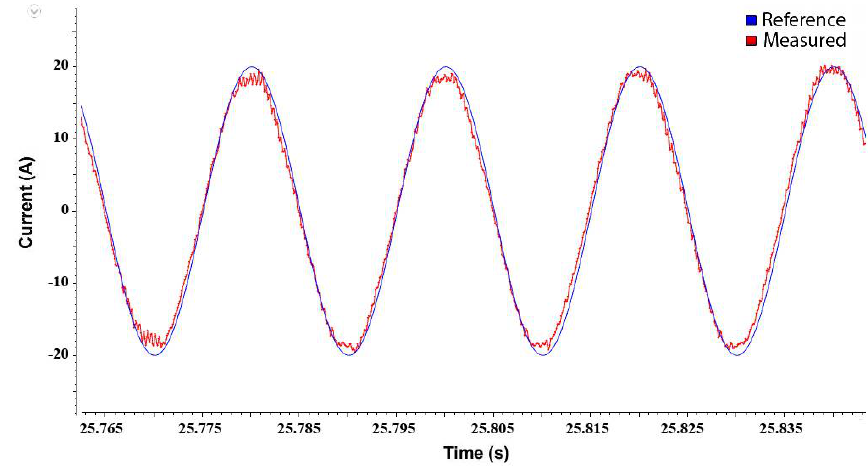
Figure 13. DSPACE-1202 front panel, Phase-A reference current at 20A.